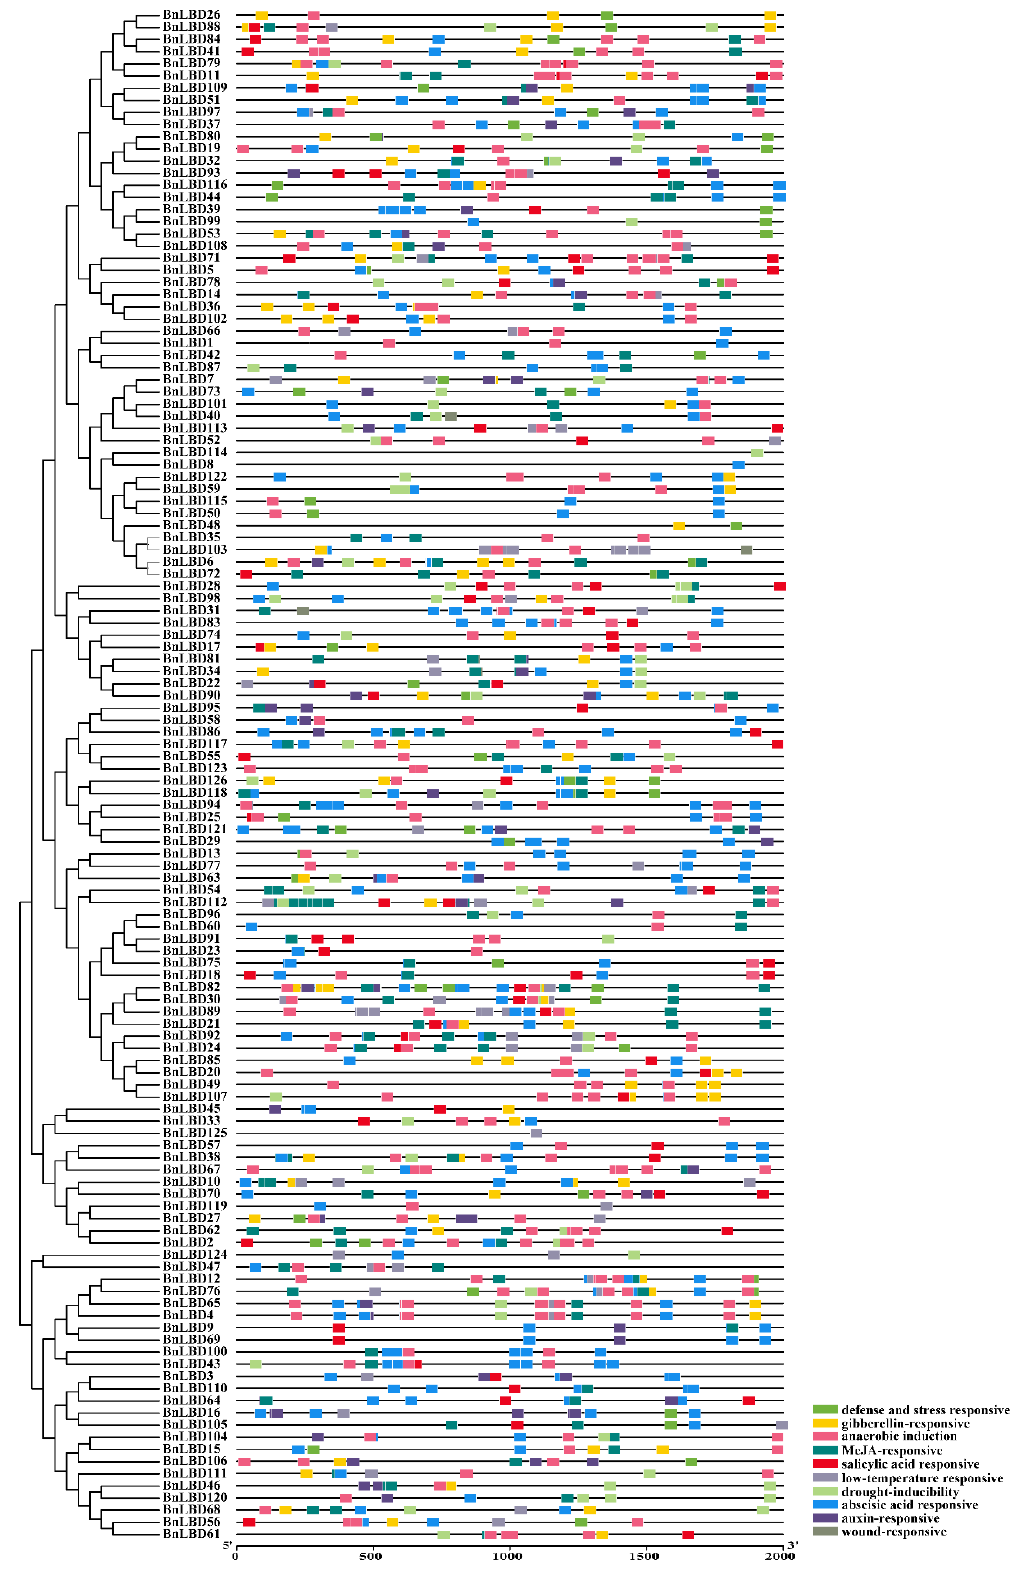
Figure 9. Cis -element analysis on the promoter regions of BnLBD genes. The presence of different cis - acting elements was determined by the PlantCARE software. Different colored boxes represent different cis -elements.